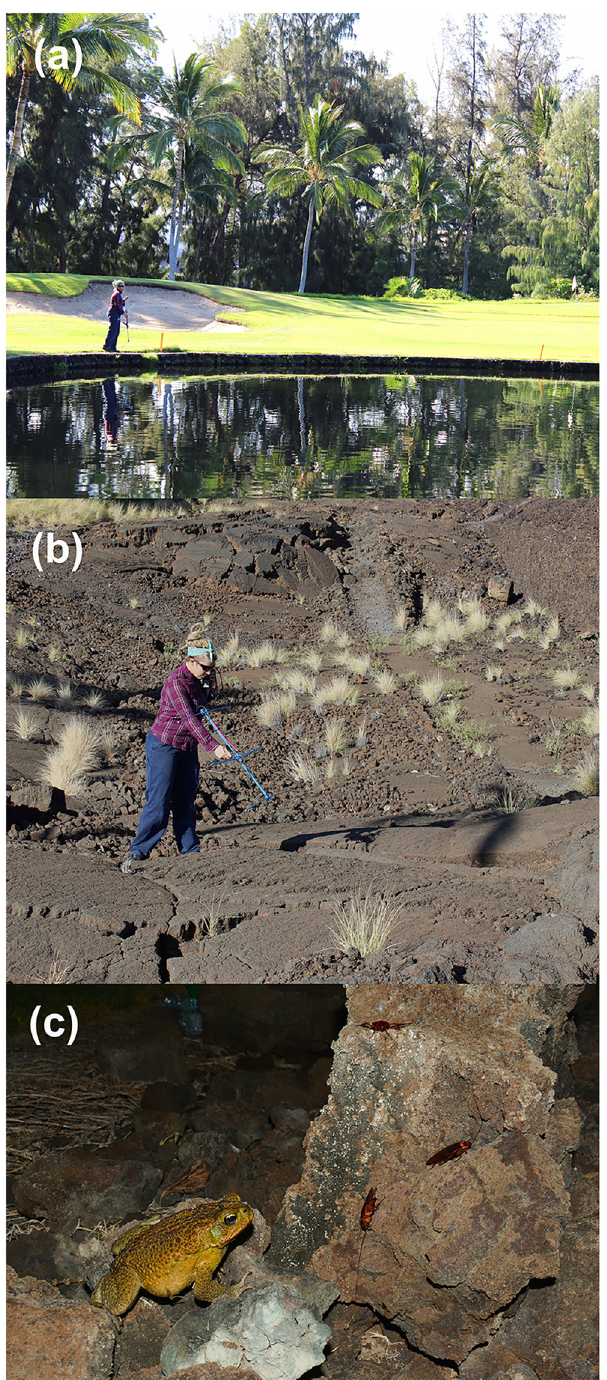
Fig 1. General habitat use by toads on the island of Hawai ’ i. On the leeward (dry) side of Hawai ’ i, dense populations of cane toads were found only in artificially irrigated areas like this golf course (a); but toads tracked at these sites often used crevices in adjacent lava flows as diurnal retreat sites (b). Observations and dissections suggest that cockroaches were the most important prey type for all toad populations that we studied (c). Photographs by M. Greenlees (a,b) and G. Clarke (c).